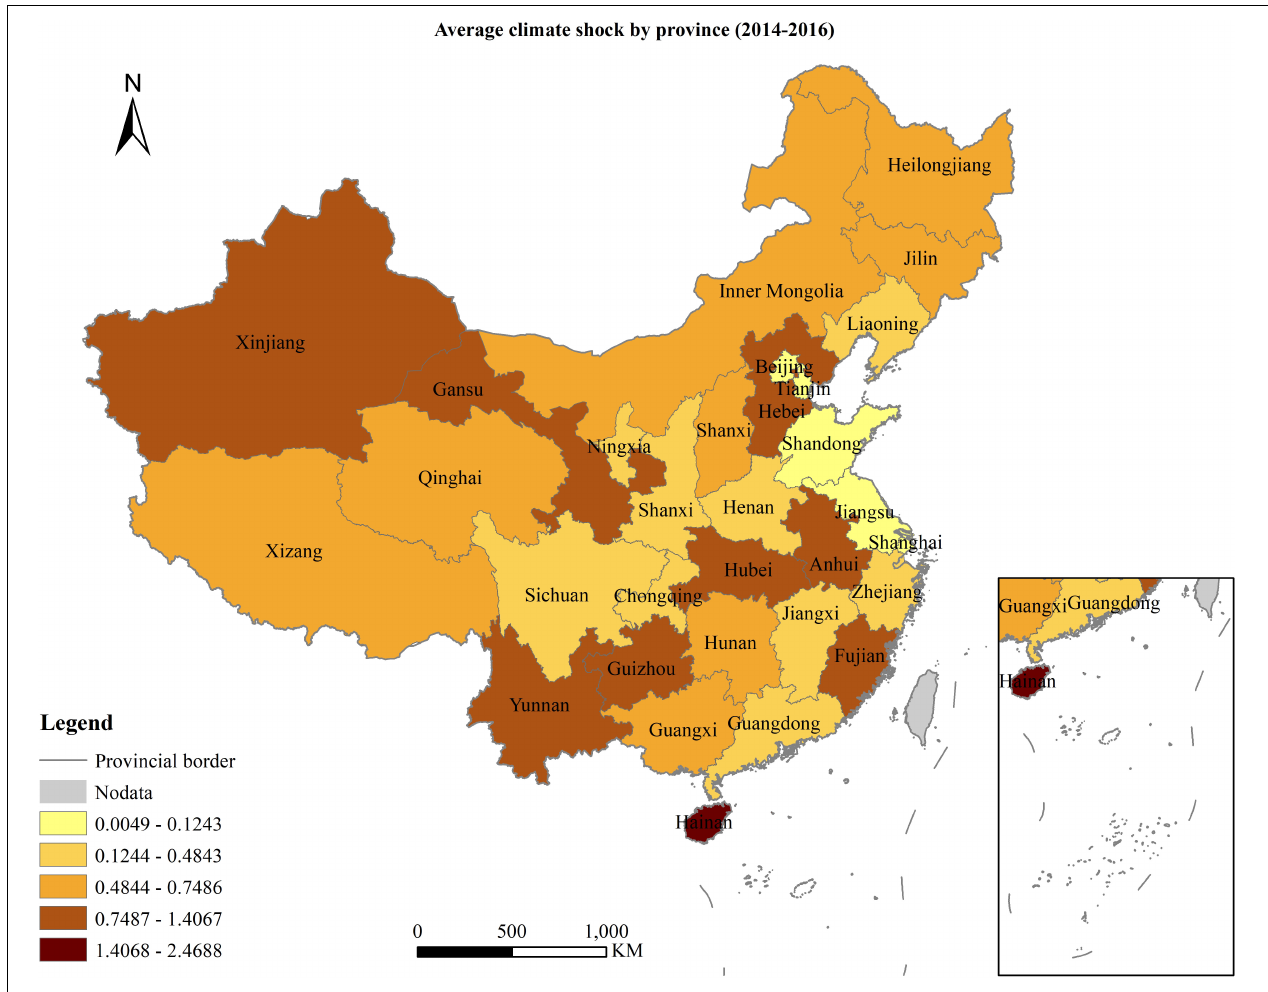
FIGURE 2 | Average climate shock by province